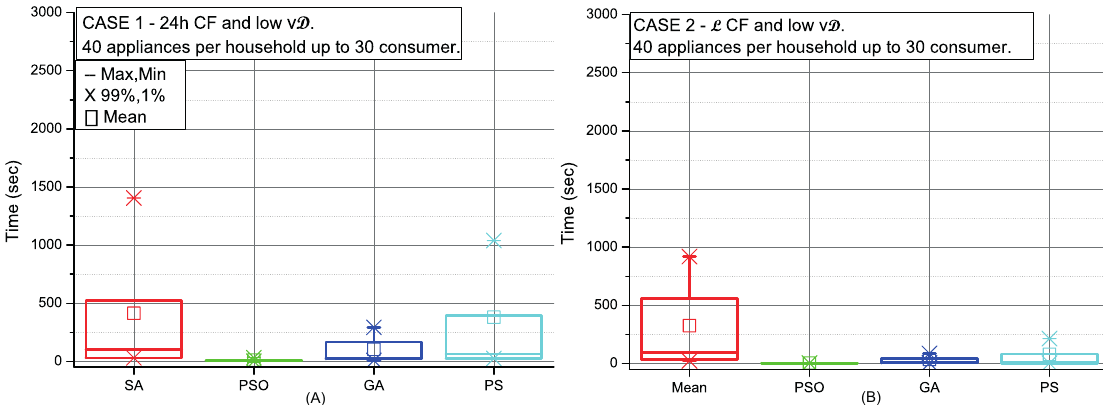
Figure 5. Distribution of the appliances, consumers and aggregator in the community.